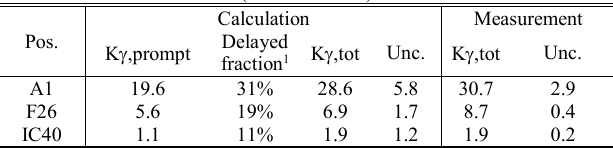
TABLE II C OMPARISON OF CALCULATED AND MEASURED TOTAL GAMMA AIR KERMA